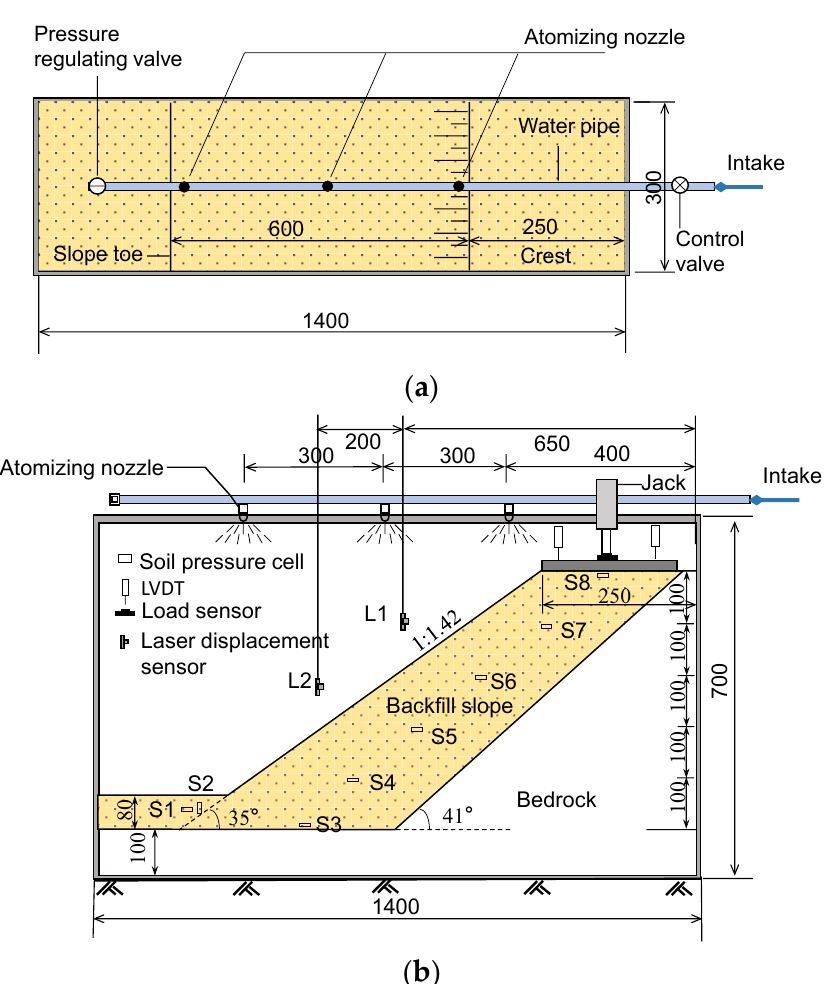
Figure 1. Setup of the model test: ( a ) plane view; and ( b ) cross section (unit: mm).